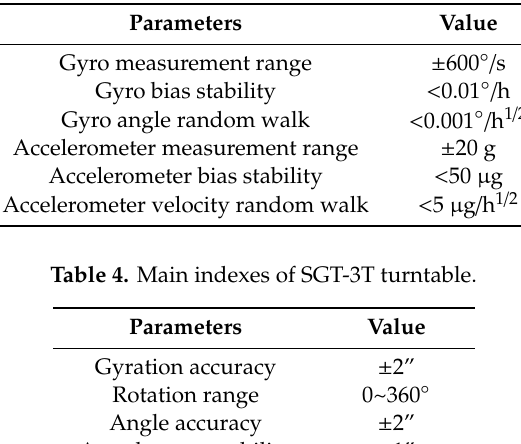
Table 3. Main parameters of gyro and accelerometer.